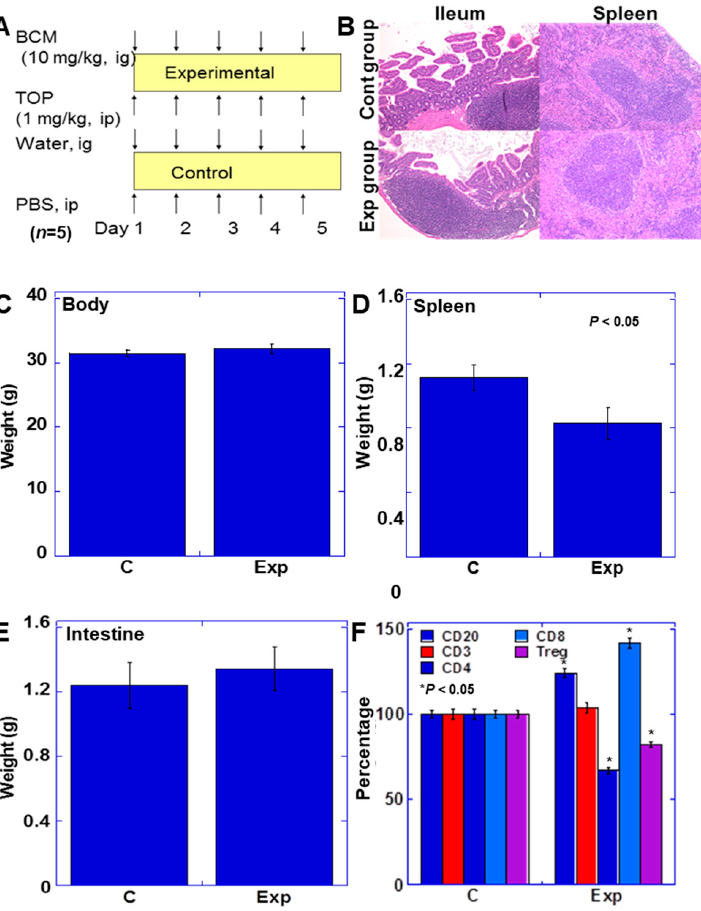
Figure 2. Effect of BCM on lymphatic tissue of mouse spleen and intestine. ( A ) BALB/c mice were treated with BCM and TOP. ( B ) Histological appearance of lymphatic tissues of the ileum and spleen. ( C – E ) Weights of the body, spleen, and intestine of BCM+TOP-treated mice. ( F ) Effect of BCM+TOP on lymphocyte subset of the intestinal mucosa. Differentiation markers were examined